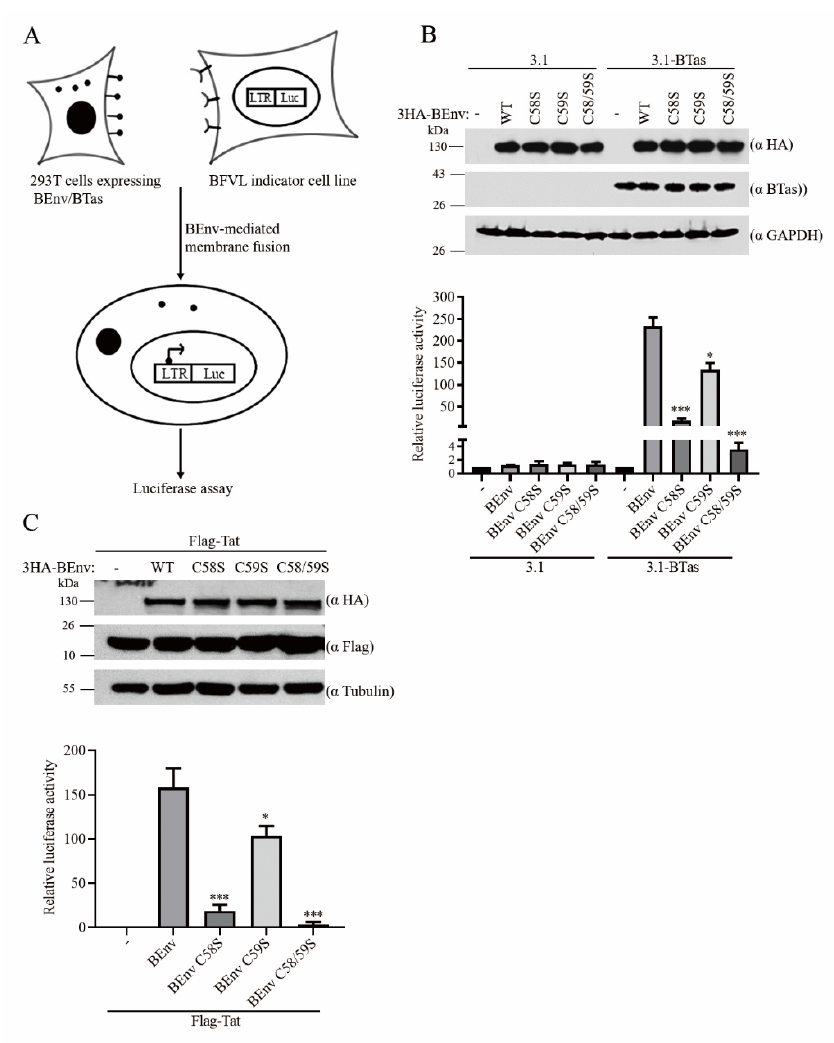
Figure 3. BEnv palmitoylation is essential for its membrane fusion activity. ( A ) Schematic of the BEnv-mediated membrane fusion assay. ( B , C ) HEK293T cells were transfected with wild type or mutant BEnv DNAs together with BTas or Tat DNAs as indicated. Forty-eight hours post-transfection, the transfected HEK293T cells (1/10 of the total) were co-cultured with BFVL or TZM-bl indicator cell lines and the luciferase activity was measured. A fraction of the transfected cells was lyzed and subjected to immunoblotting to monitor BEnv and BTas or Tat expression. Data presented were obtained from three independent experiments. P-values are indicated as follows: * p < 0.05, *** p < 0.0001. GAPDH,glyceraldehyde-3phosphate dehydrogenase.